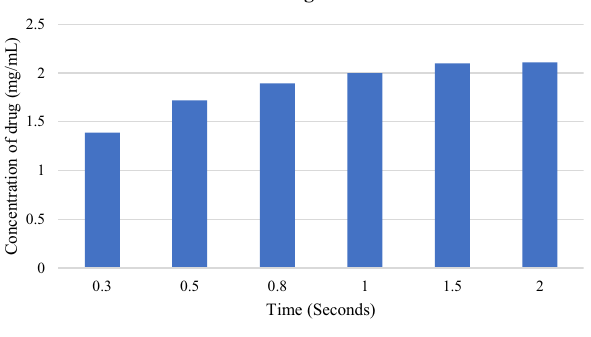
Fig. 9 Drug release pattern for five days